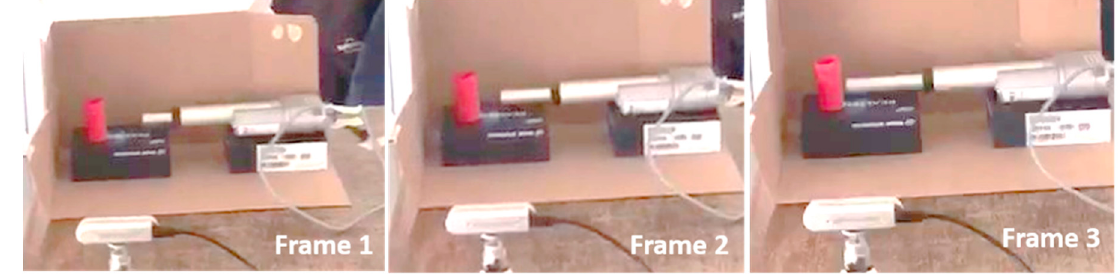
Figure 6. Closed loop control adopted for tracking application.